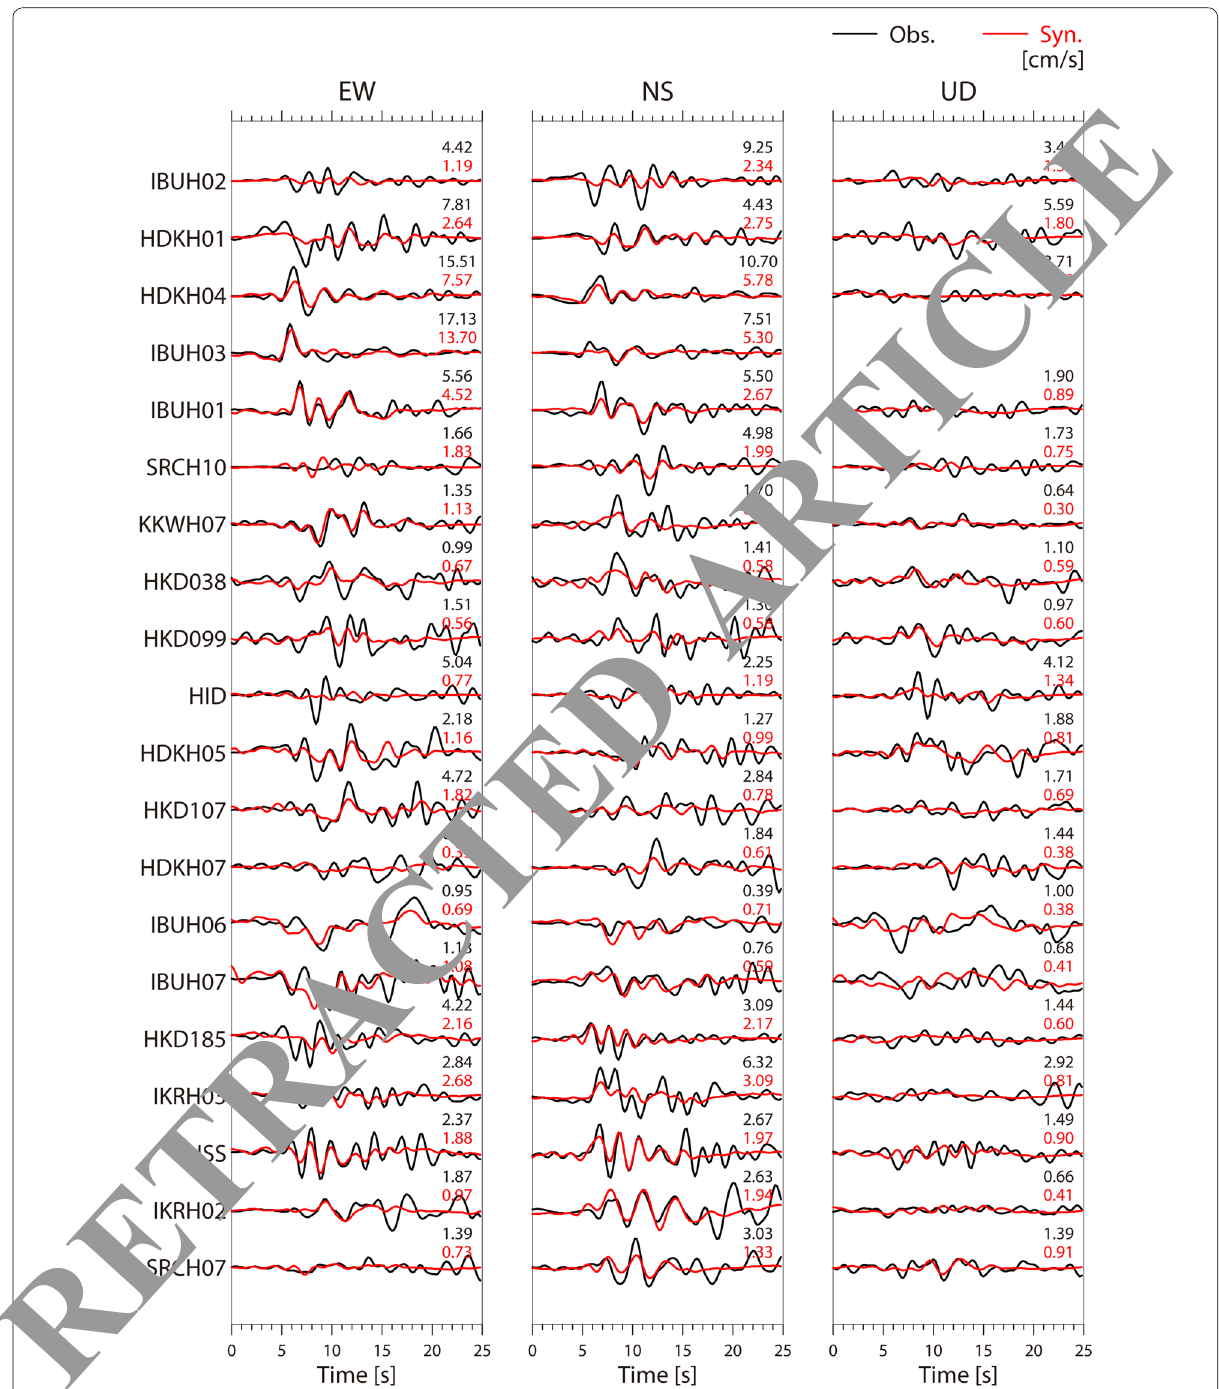
Fig. 3 Comparison of observed (black) and synthetic waveforms (red) in the source inversion. The number on the upper right-hand corner of each waveform denotes the maximum absolute amplitude in cm/s